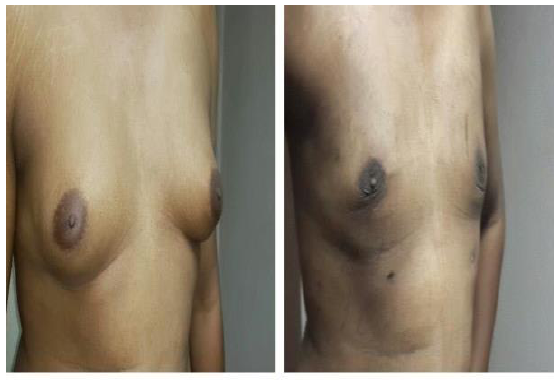
Figure 9 (a) Oblique view, patient with Simon 3 befor and after operative